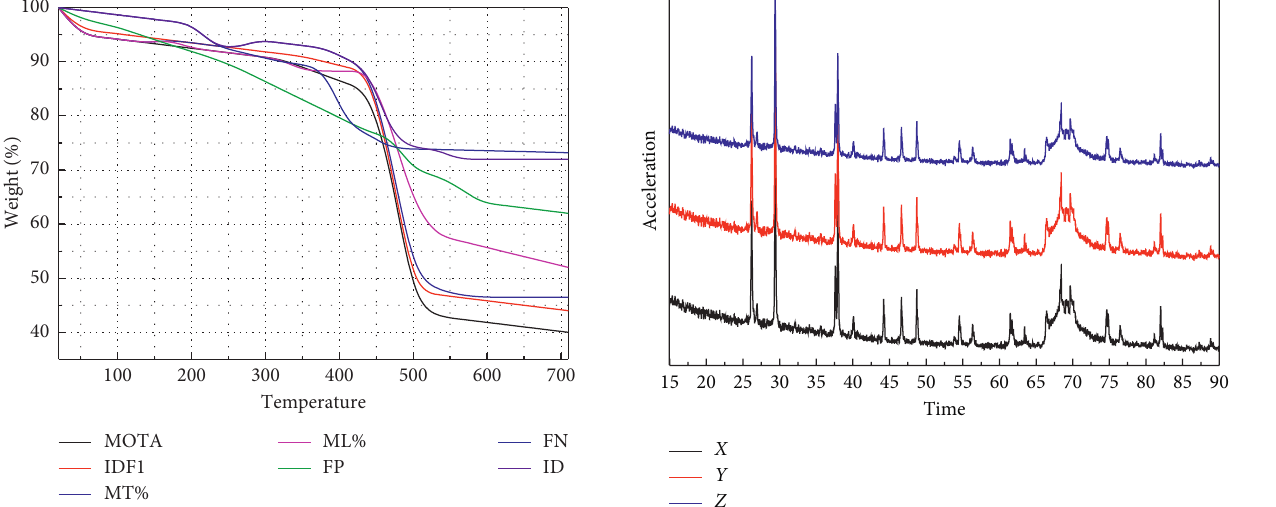
Figure 9: Changes in left foot acceleration and angular velocity during